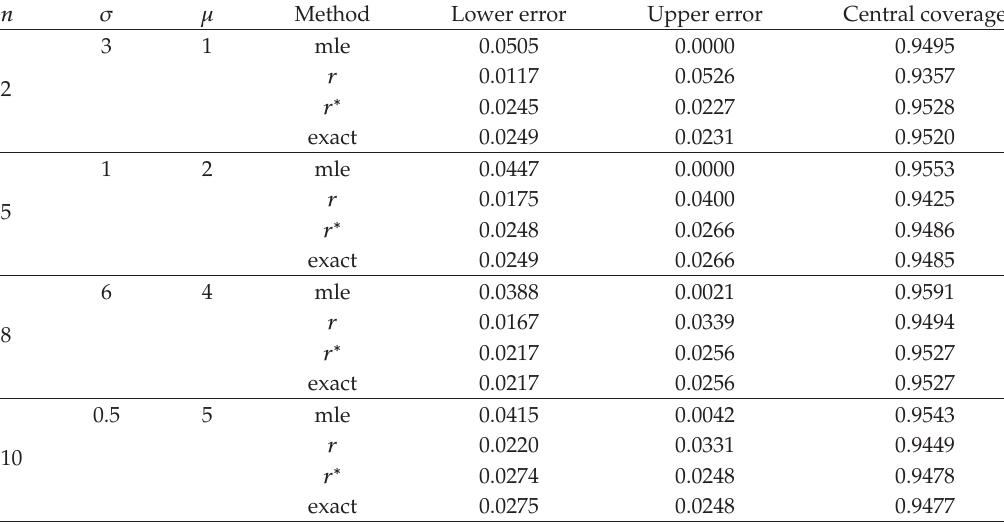
Table 3: Results from simulation studies for the parameter of interest σ